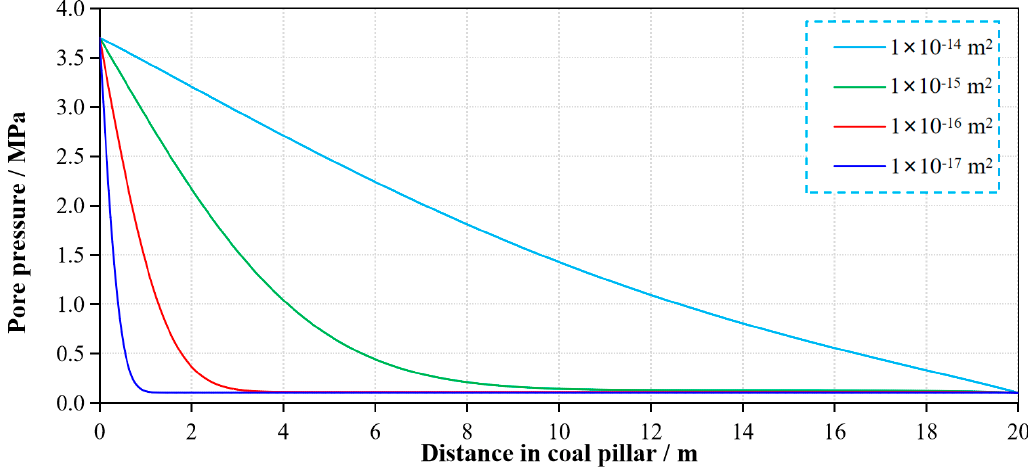
Figure 11. Pore pressure distribution of the coal pillar dam under different permeability.